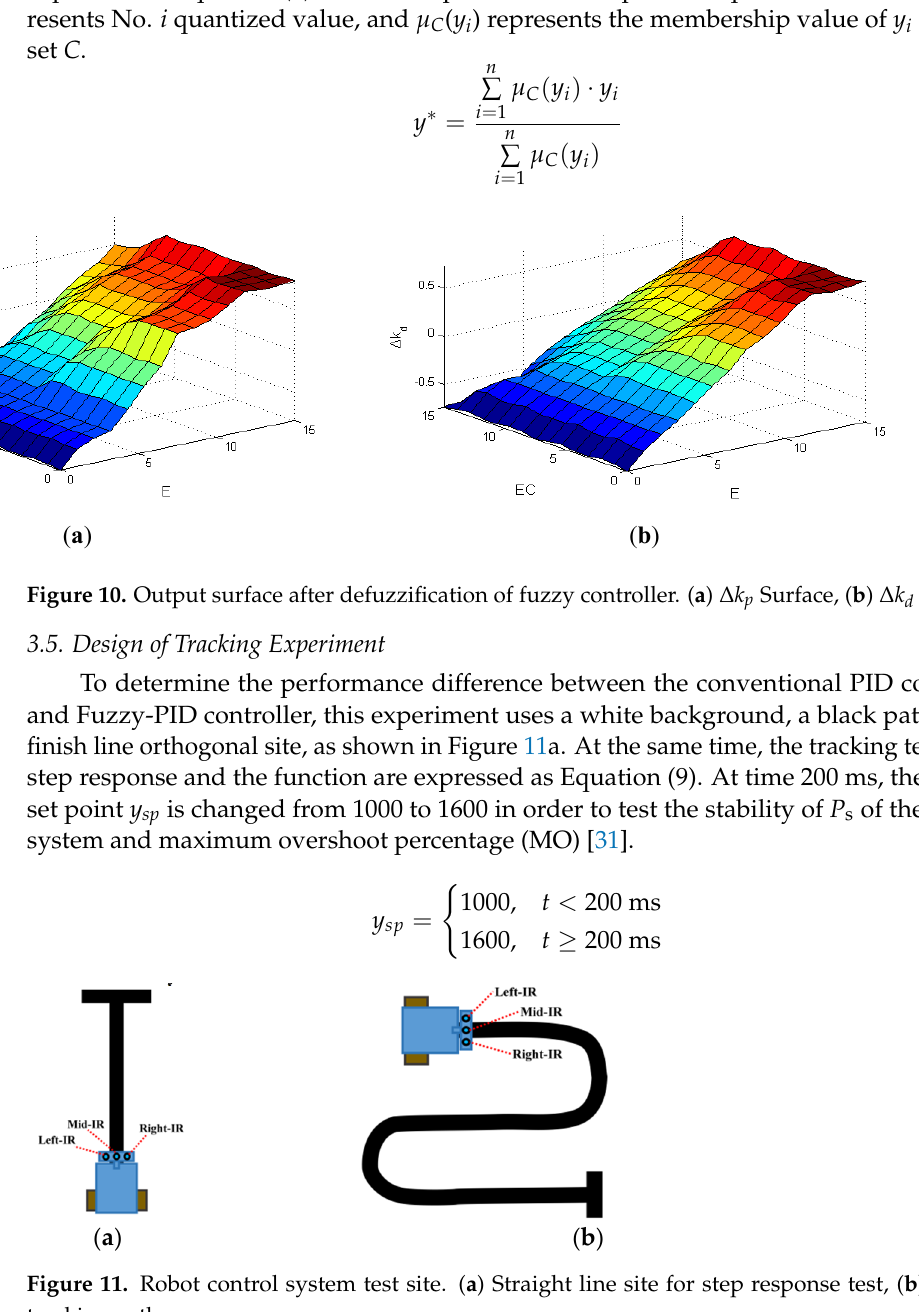
Figure 11. Robot control system test site. ( a ) Straight line site for step response test, ( b ) S-curve tracking path.